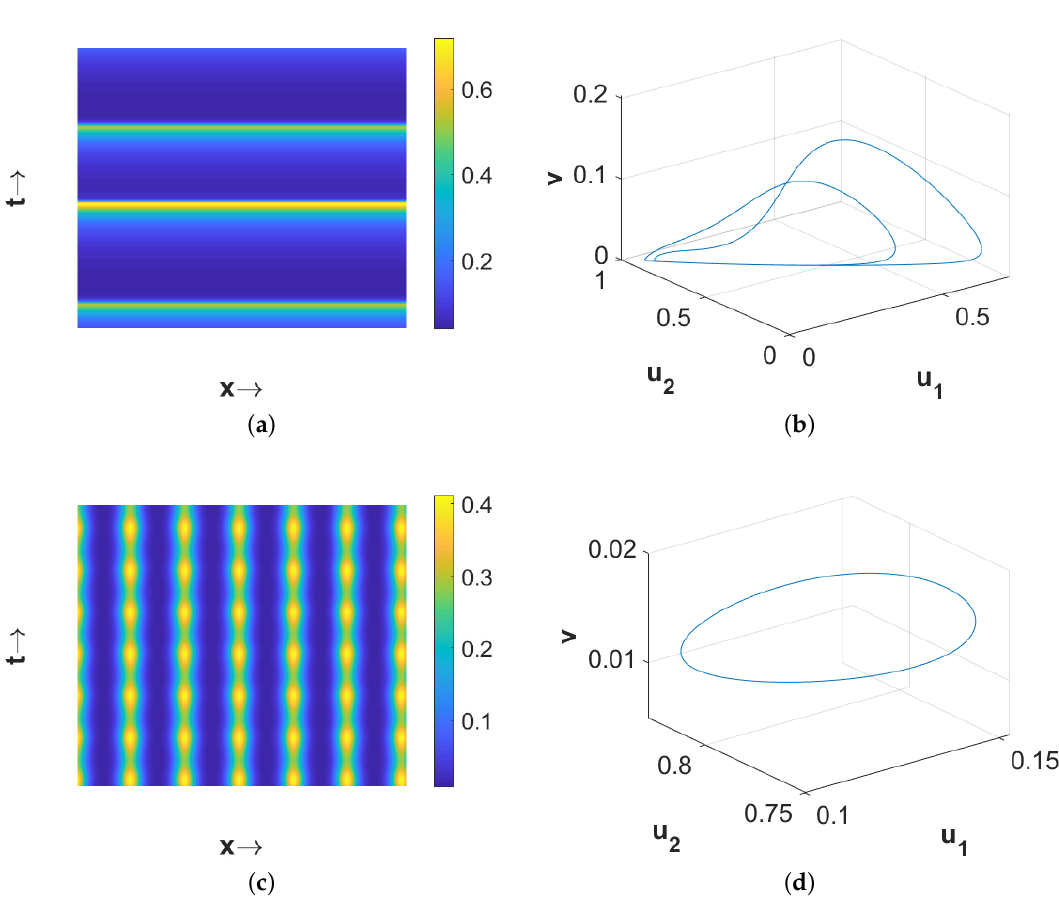
Figure 13. ( a ) Plot of spatial pattern exhibited by u 1 , ( b ) corresponding phase portrait of the average densities of three species for (cid:101) = 8.0, d 3 = 1.0. ( c ) Plot of spatial pattern exhibited by u 1 , ( d ) corresponding phase portrait of the average densities of three species for (cid:101) = 8.0, d 3 = 10.0. Spatial domain size is [ − 50,50 ] and other parameter values are mentioned in